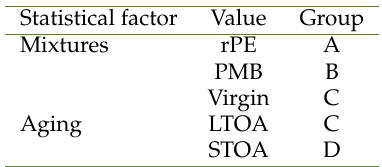
Table 5. Tukey’s pairwise comparisons of |E*| means Statistical